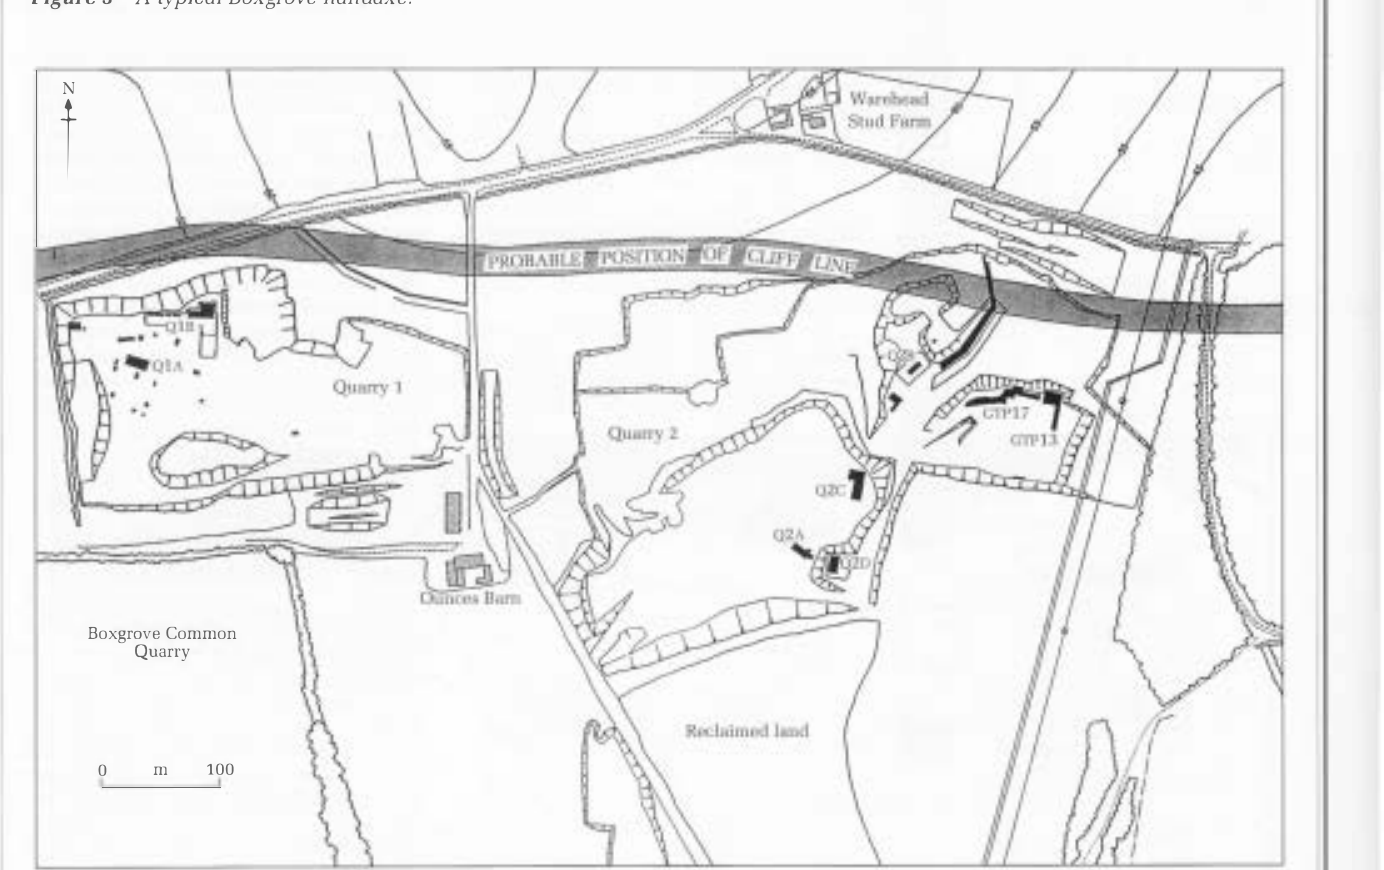
Figure 3 A typical Boxgrove hand axe.